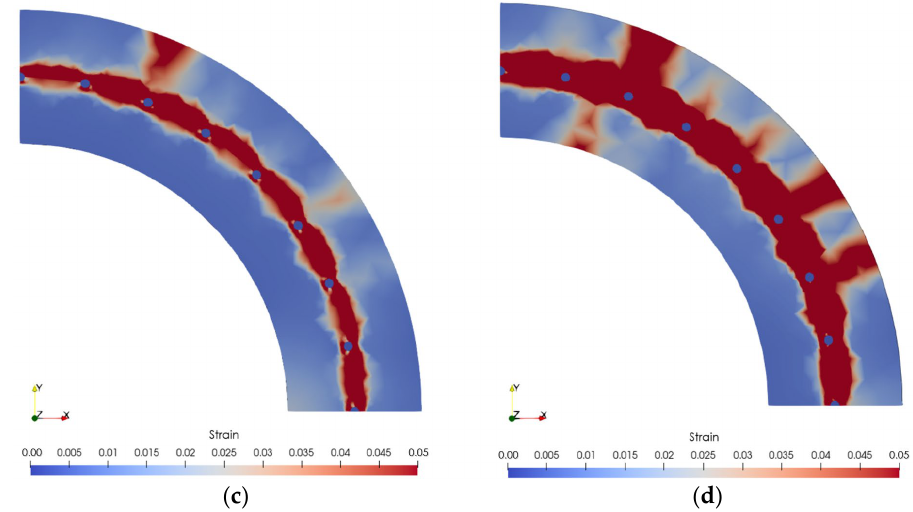
Figure 9. Concrete strain distributions of the corroded spun pile. ( a ) 4.68% corrosion degree. ( b ) 9.67% corrosion degree. ( c ) 14.74% corrosion degree. ( d ) 18.56% corrosion degree.